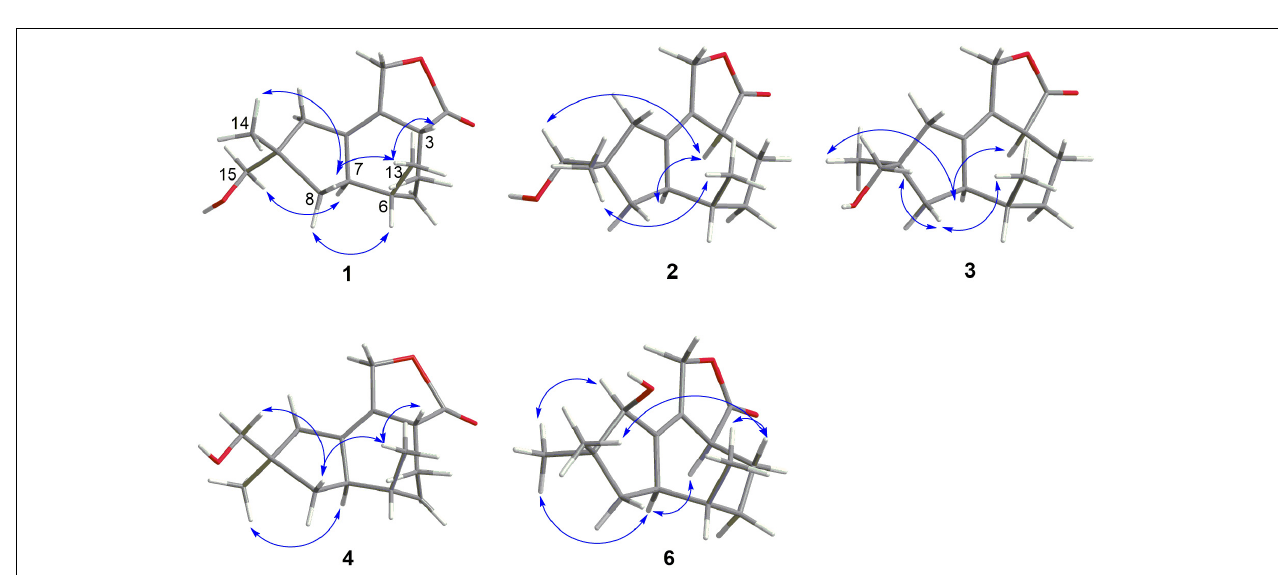
FIGURE 3 | Key COSY and HMBC correlations of compounds 1 – 6 .